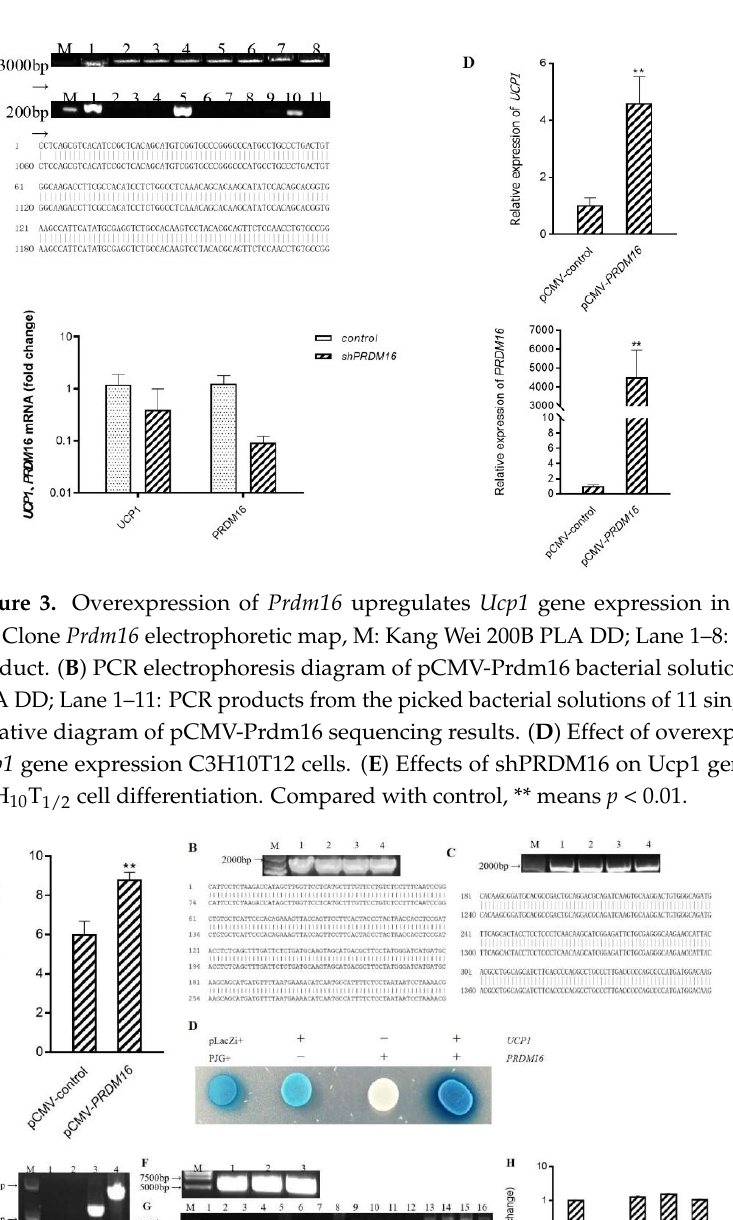
Figure 4. Prdm16 capable of activating Ucp1 promoter ( A ) Effect of Prdm16 on Ucp1 promoter (double luciferase report gene method) ( B ) PCR electrophoresis diagram and sequencing comparison diagram of pLacZi-Ucp1 bacterial solution. M: Kang Wei 200B PLA DD;Lane 1–4: PCR products from the picked four single-colony bacterial solutions. ( C ) PCR electrophoresis diagram and sequencing comparison diagram of pJG-Prdm16 bacterial solution. M: Kang Wei 200B PLA DD; Lane 1–4: PCR products from the picked four single-colony bacterial solutions. ( D ) Effect of Prdm16 on Ucp1 promoter (yeast one-hybrid assay) ( E ) Clone electrophoretic images of Ucp1 promoter with different lengths. ( F ) PGL3-Basic enzyme digestion electrophoresis diagram ( G ) PCR electrophoresis map of bacterial solution after ligation of Ucp1 promoter with different lengths to pGL3-Basic. ( H )